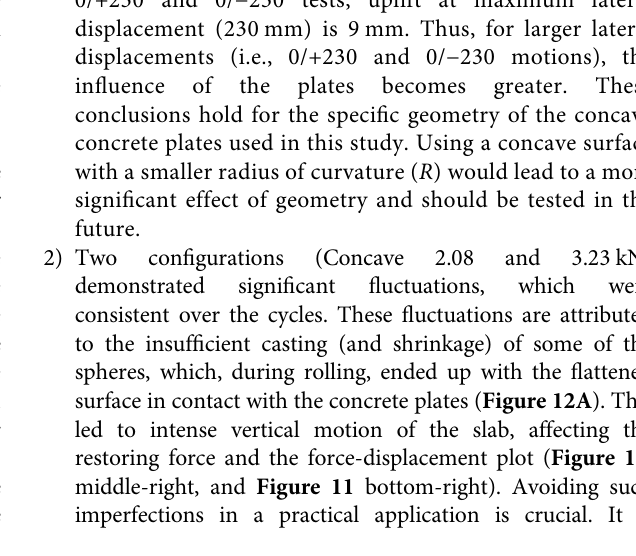
Frontiers in Built Environment |